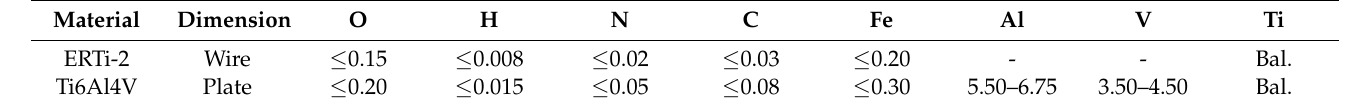
Table 1. Nominal chemical composition of the used Ti wire and substrate material (wt.%).